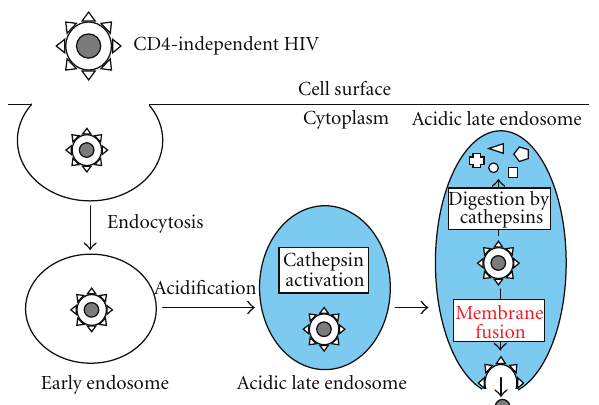
Figure 5: Entry pathway of CD4-independent HIV. Blue area indicates acidic